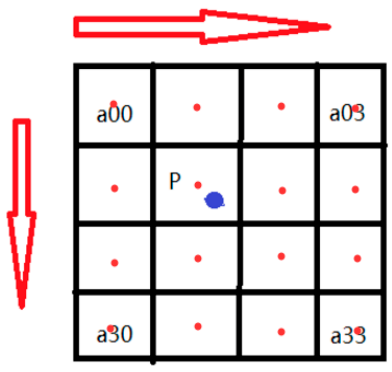
Figure 3. Pixel value calculation.